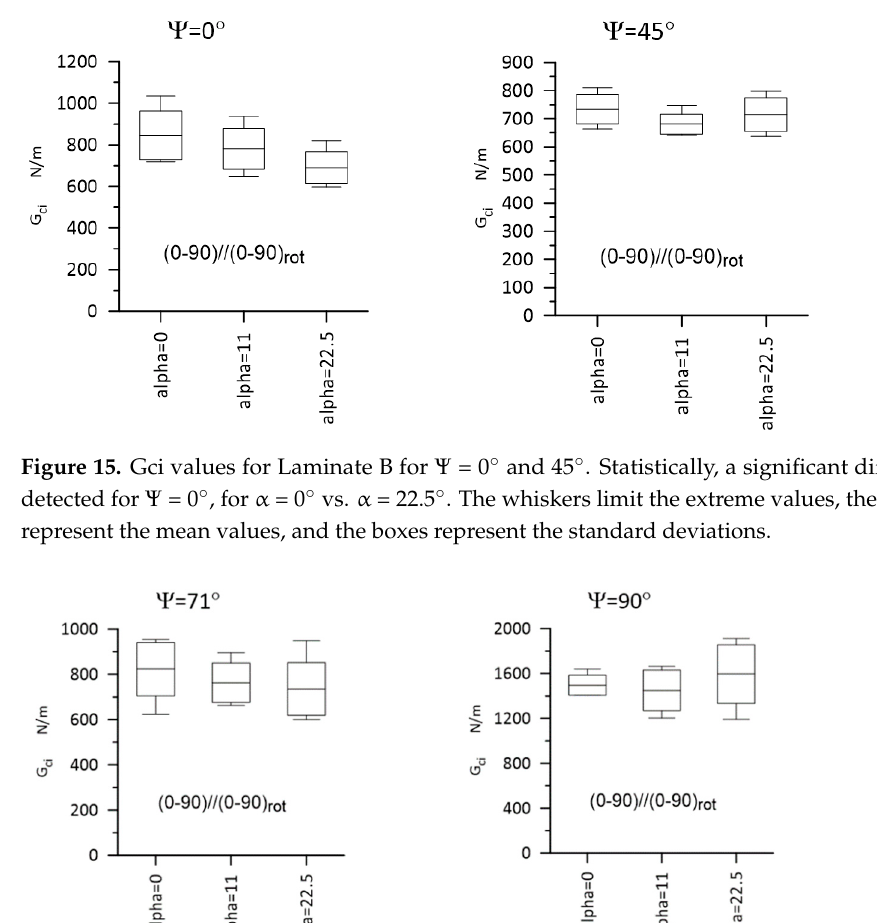
Figure 14. Gci values for Laminate A, for Ψ = 71 ◦ and Ψ = 90 ◦ . Statistically significant differences were detected for Ψ = 71 ◦ , for α = 0 ◦ vs. α = 75 ◦ ; α = 75 ◦ vs. α = 90 ◦ and for Ψ = 90 ◦ , for α = 45 ◦ vs. α = 90 ◦ . The whiskers limit the extreme values, the middle bars represent the mean values, and the boxes represent the standard deviations.